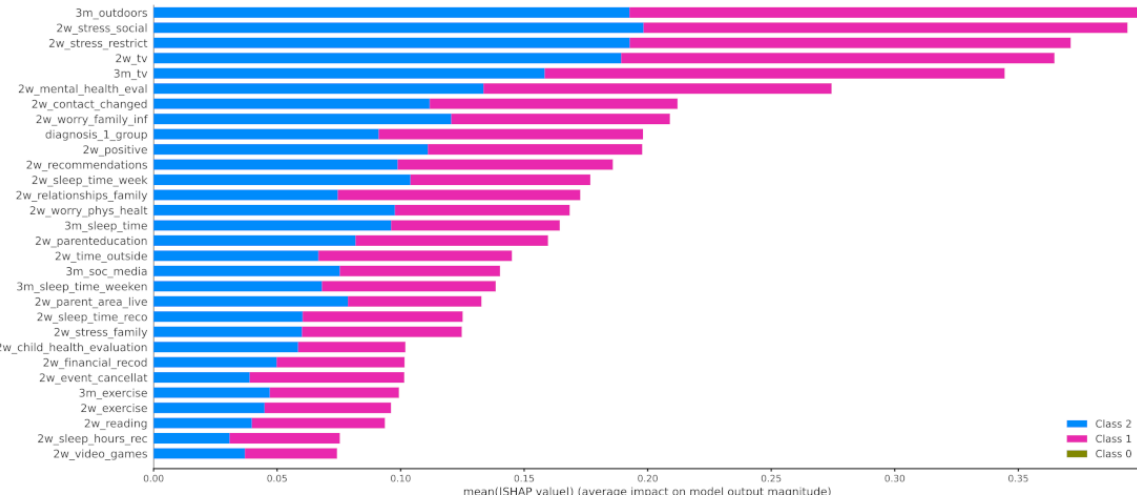
Figure 17. Mean SHAP values of patients from class 0 and class 2.